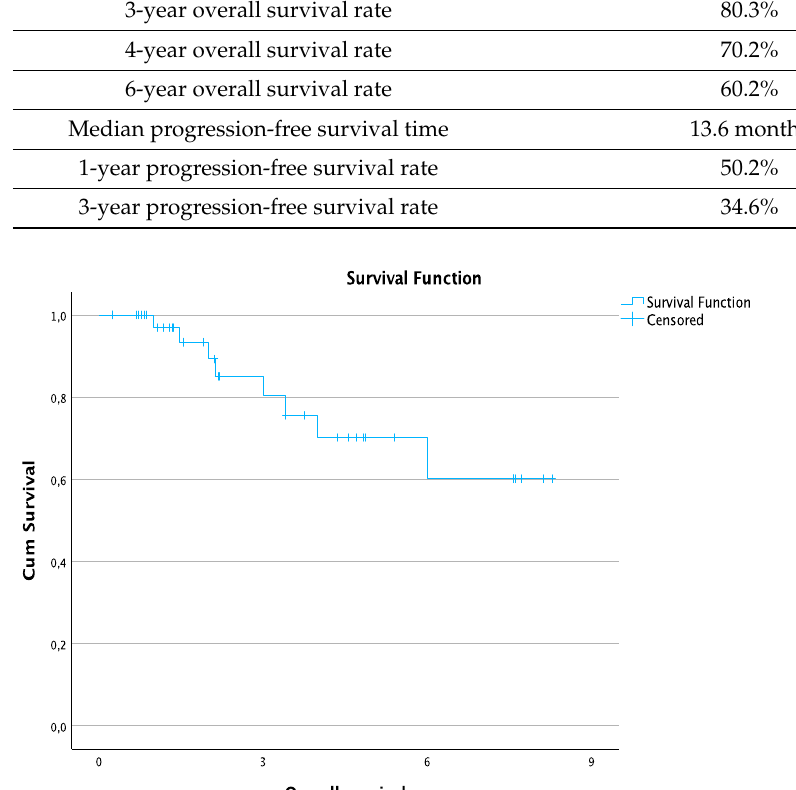
Figure 2. Overall survival for all patients in years.